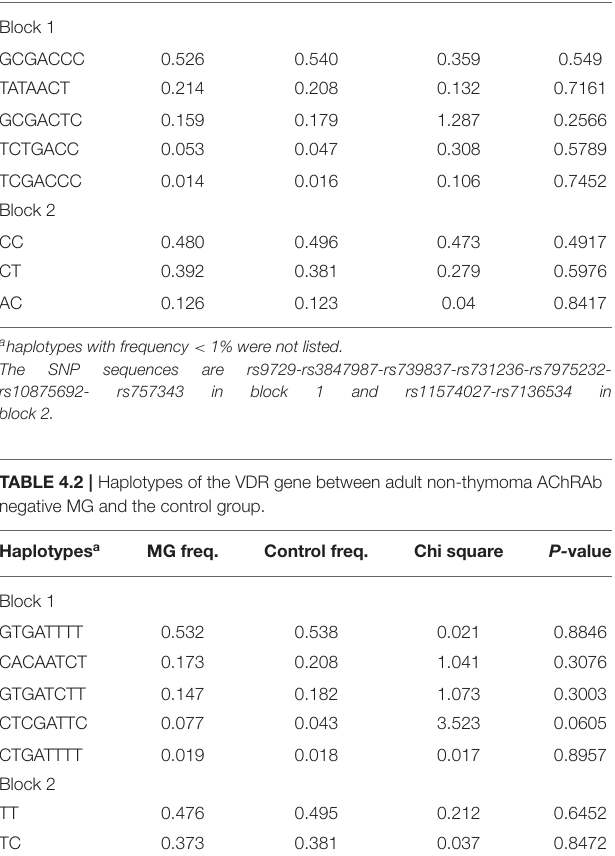
TABLE 4.1 | Haplotypes of the VDR gene between MG and the control group. Haplotypes a MG freq. Control freq.